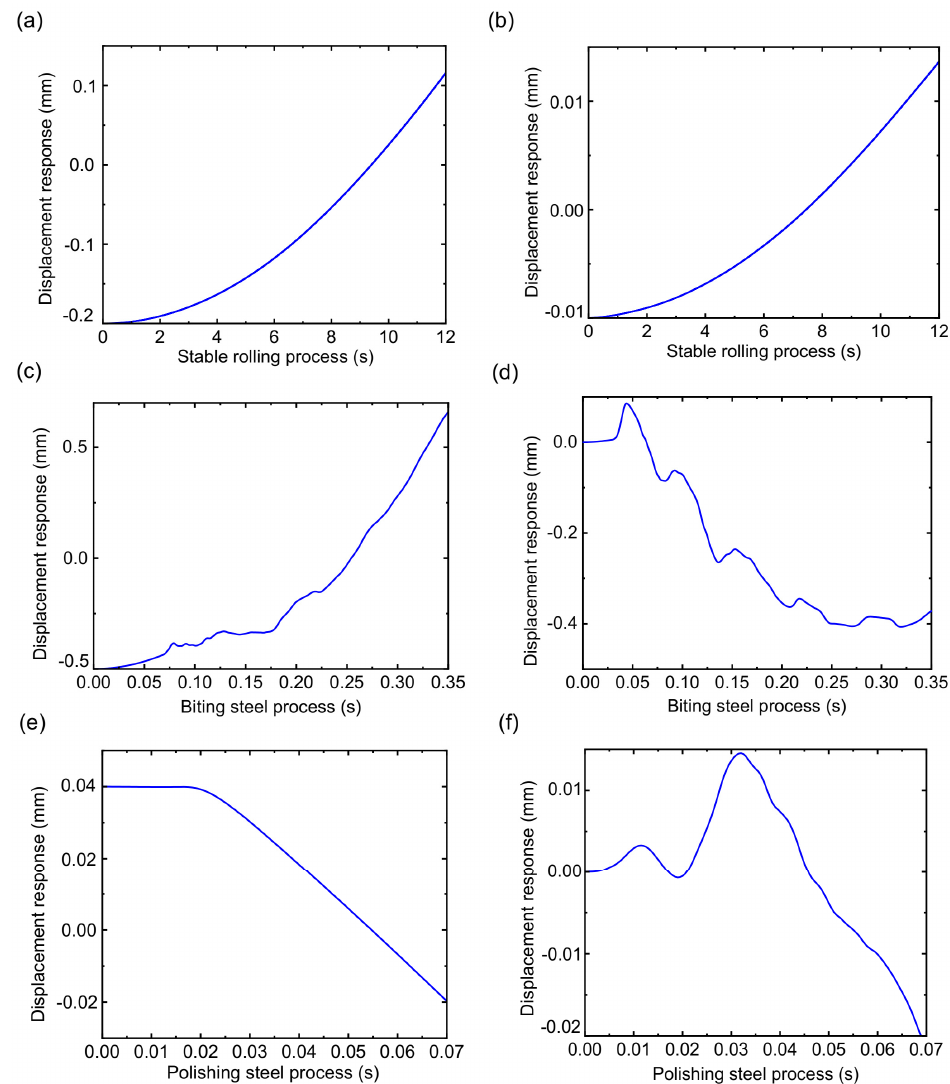
Figure 11. Transient displacement response of the system: ( a ) stable rolling process of the 1.6 mm, ( b ) stable rolling process of the 3.2 mm, ( c ) biting steel process of the 1.6 mm, ( d ) biting steel process of the 3.2 mm, ( e ) polishing steel process of the 1.6 mm, and ( f ) polishing steel process of the 3.2 mm.